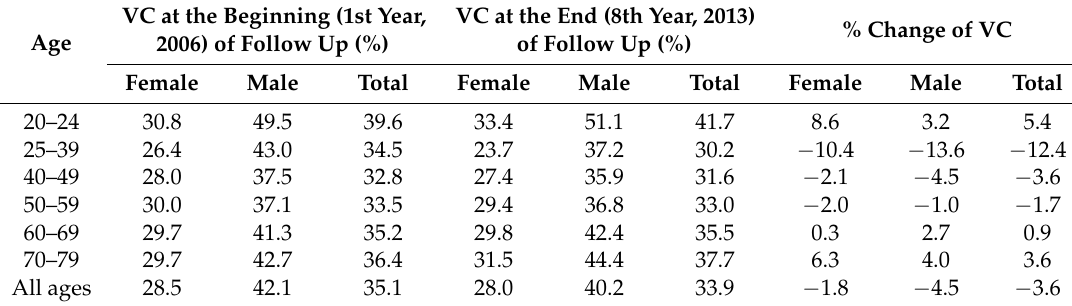
Table 2. Tetanus vaccination coverage (VC, %) and percentage change among adults aged between 20 and 79 years in Taiwan’s representative cohort at the beginning and end of 8-year follow up by age and gender (2006–2013, n = 771,443).